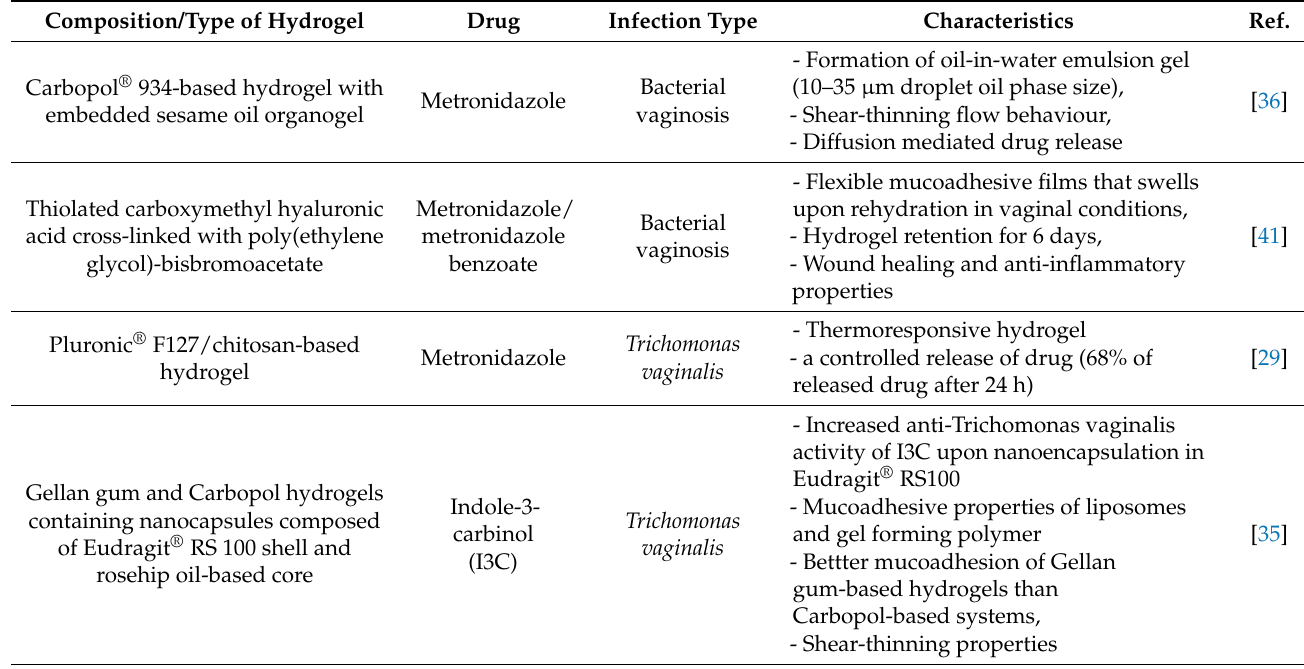
Table 1. The characteristics of antimicrobial polymer-based hydrogel systems for gynaecological treatment. Composition/Type of Hydrogel Characteristics